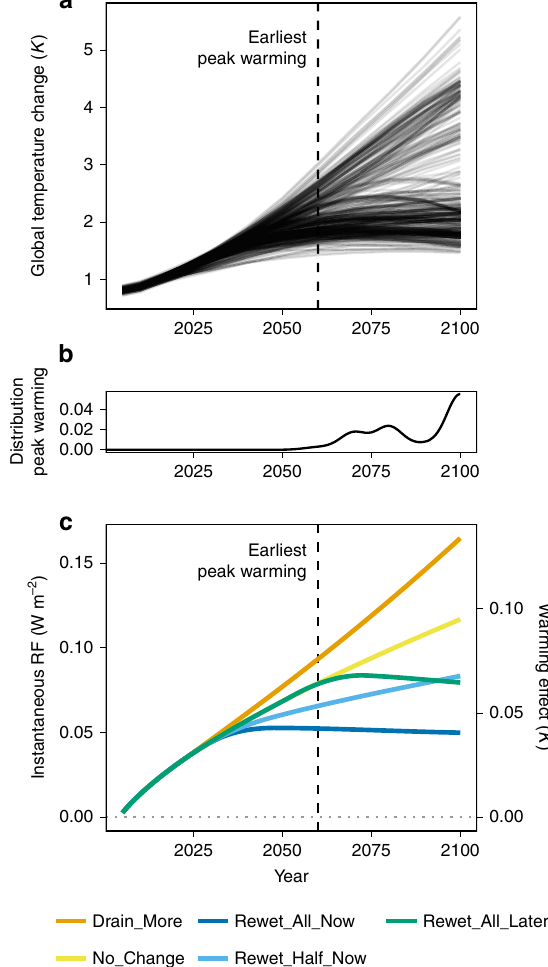
Fig. 1 Global warming and climatic effects of peatland management. Mean global temperature change relative to 2005 ( a ) and frequency distribution of the timing of peak warming ( b ) according to AR5 model pathways (downloaded from IAMC AR5 Scenario Database) are shown compared with radiative forcings (RF) and estimated instantaneous warming effects of global peatland management scenarios (panel c , own calculations). Please note that in panel c ) forcing of peatlands that remain pristine is assumed to be